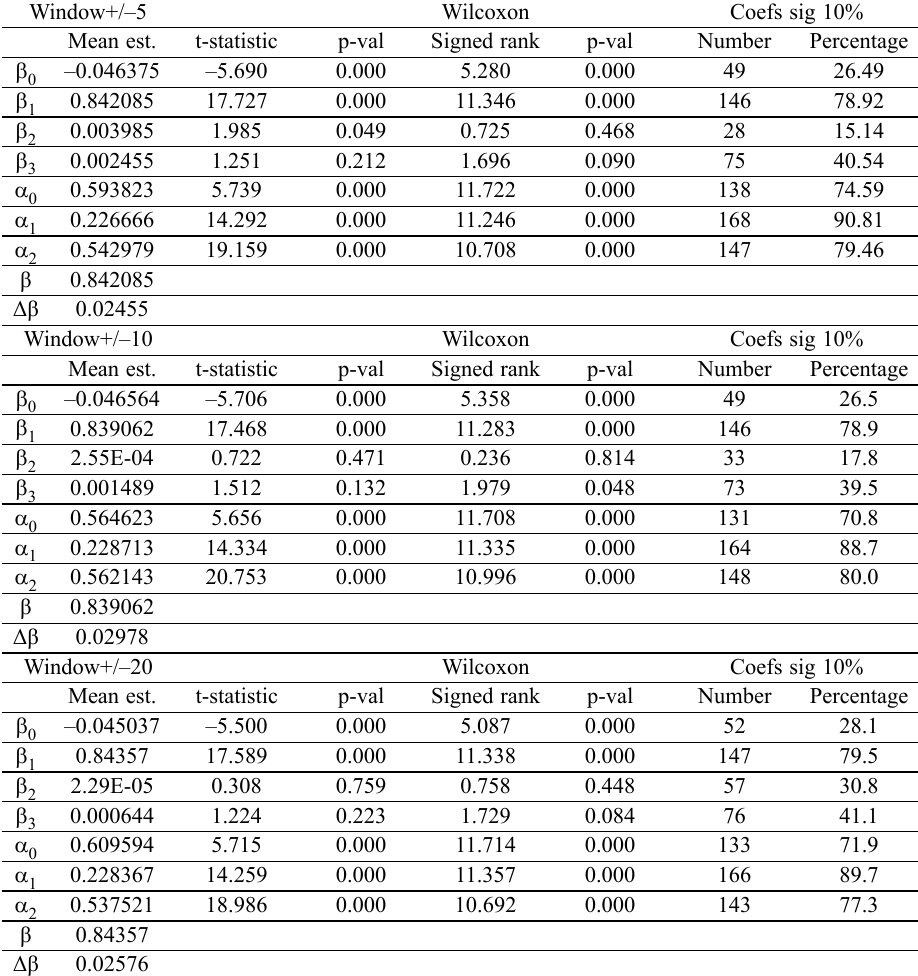
Table 3. Results for registry dates